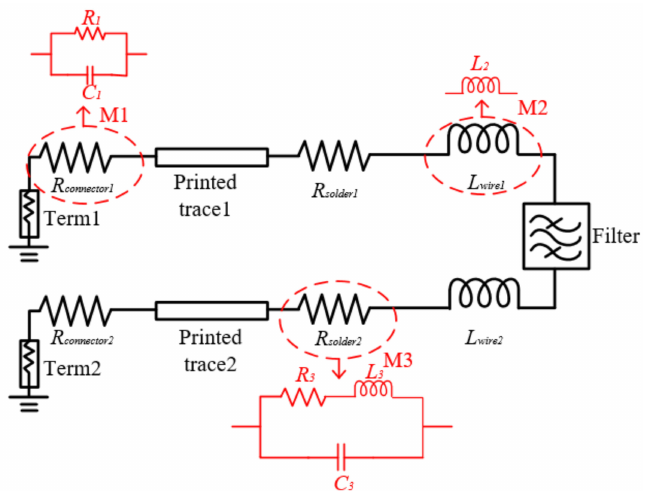
Figure 10. Equivalent circuit model of the filter